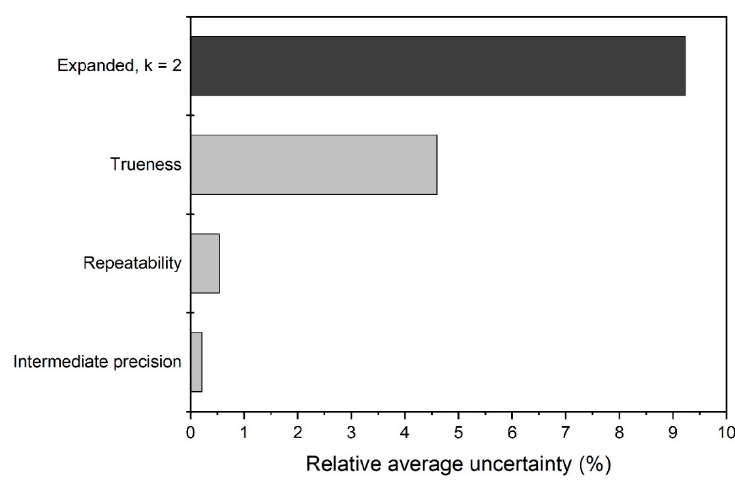
Figure 2. Relative average standard and expanded measurement uncertainties (%) estimated for particle size results from the validated cuvette-CLS method.